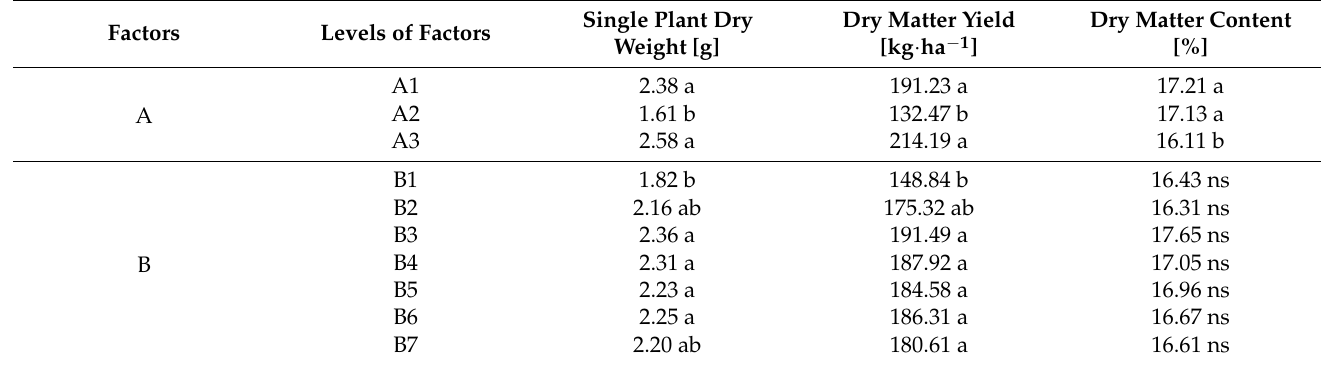
Table 6. Average values of plant dry matter accumulation dynamics for cultivars (A) and fertilizers (B). Factors Levels of